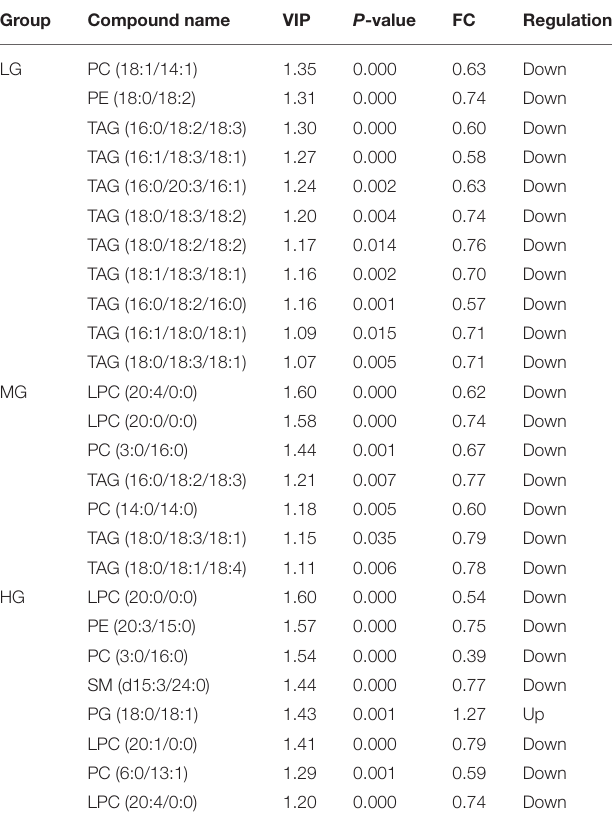
TABLE 2 | Potential differential metabolites identified significantly different in liver in each